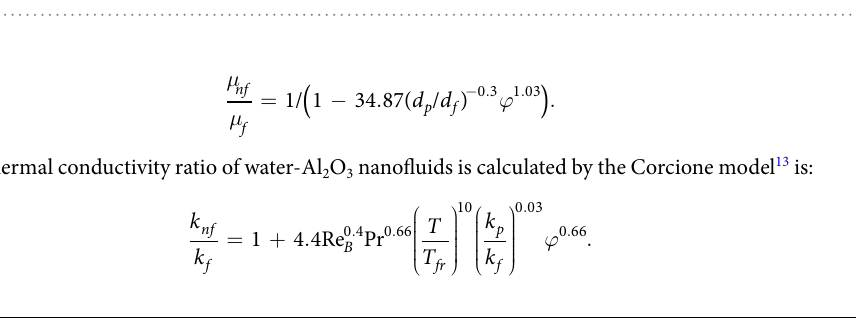
Figure 13. Variation of the streamlines (left), isotherms (middle), and nanoparticle distribution (right) evolution by Hartman number ( Ha ) for Ra = 10 5 , φ = 0.02, k w = 0.76 and D =